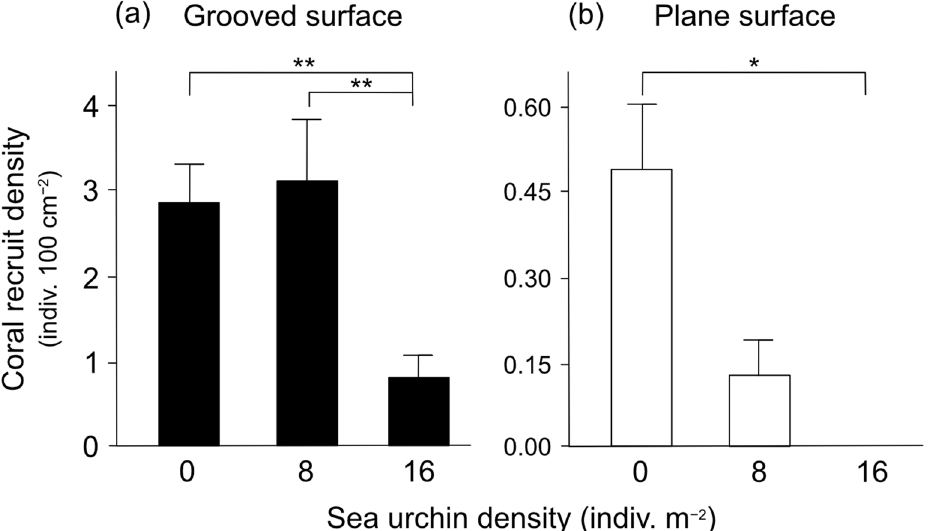
Figure 4. The effect of the three density conditions of Diadema savignyi on coral recruitment density ( a ) on grooved surface plates and ( b ) plane surface plates at the end of 3-month experiment. Average + SE are shown. Stars denote statistical significance at p < 0.05 (*) and p < 0.01 (**). No coral recruits occurred on plane plates in the 16 indiv. m −2